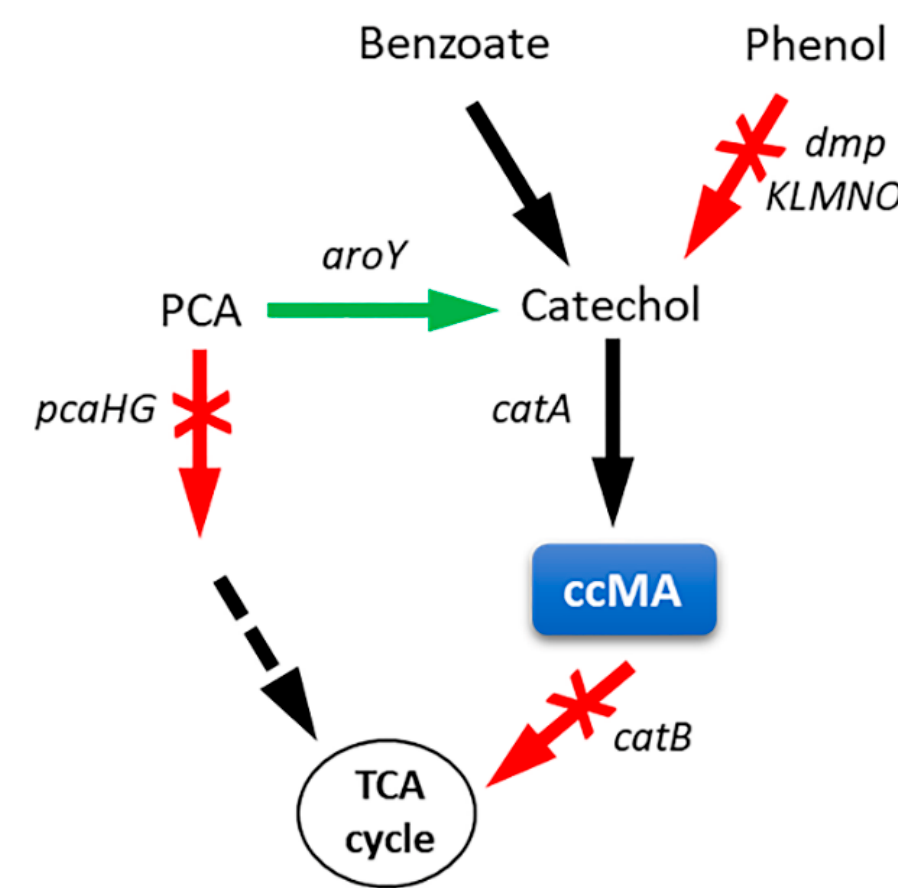
Figure 5. Metabolic engineering of Pseudomonas putida KT2440 to convert protocatechuic acid (PCA) and catechol derived from benzoate and phenol into ccMA [88]. Encoding genes: aroY , protocate- chuate decarboxylase; catA , catechol 1,2-dioxygenase; catB , muconate cycloisomerase; dmpKLMNOP , phenol monooxygenase; pcaHG , protocatechuate 3,4-dioxygenase. Black arrows show the endogenous pathway; green arrows show overexpressed pathways; red crossed arrows identify deleted pathways; dashed arrows show additional multi-step pathways.